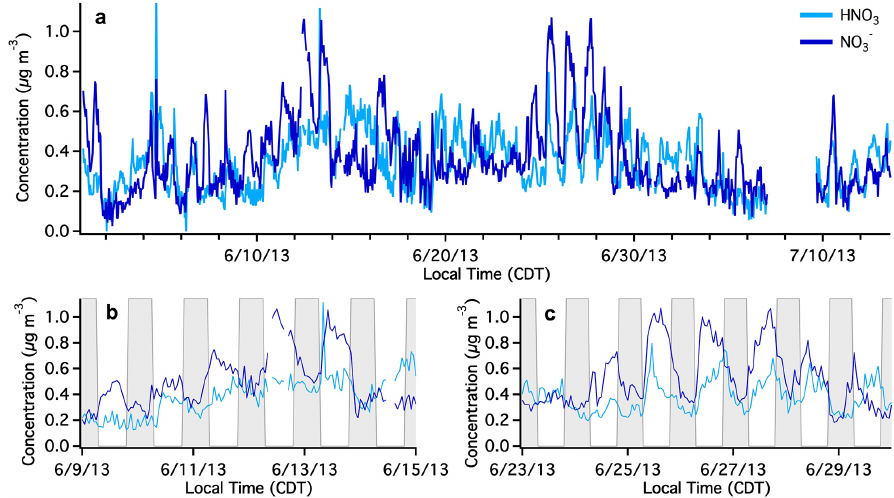
Figure 1. Time series of hourly averaged HNO 3 and NO − including the (a) full time series and two subsets, with shading indicating nighttime, that encompass the periods of elevated NO − (b) 9 to 15 June and (c) 23 to 30 June